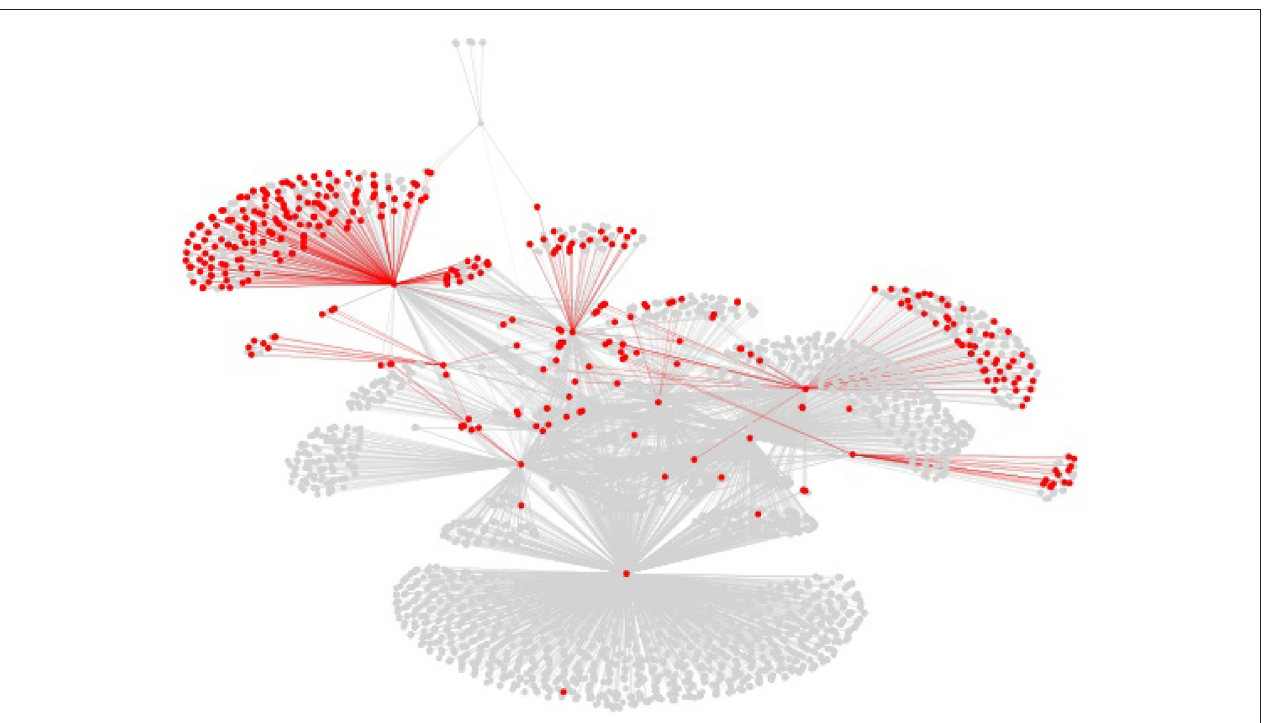
FIGURE 6 | Structure of the virus-host protein–protein interaction network for the Influenza A virus in the Viruses.STRING dataset (gray) and overlapping proteins and interactions in the VirusMentha dataset